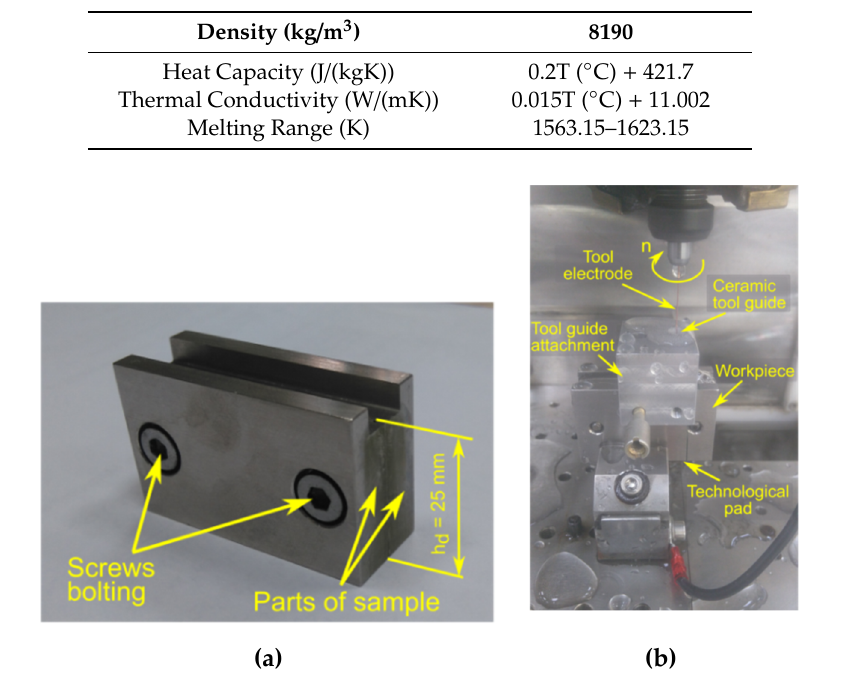
Figure 1. A photograph of the sample. ( a ) h d —Maximal drilling depth; ( b ) the experimental setup of the electrode guiding system.